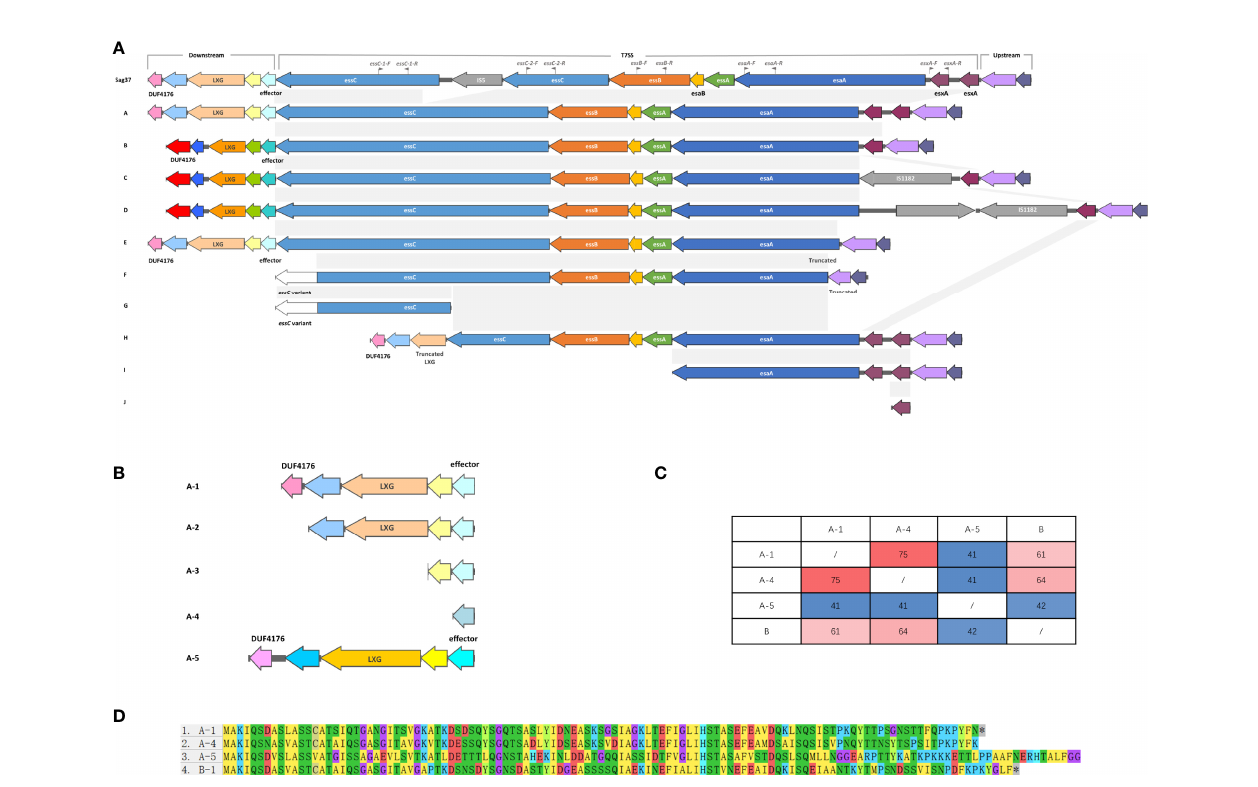
FIGURE 2 | (A) Schematic representation of the T7SS gene clusters and their fl anking genes, both upstream and downstream. In the downstream fl anking genes, genes encoding similar conserved domains/motifs are indicated with similar colors; genes in pink and light purple encode DUF4176 domain-containing proteins; genes in beige and orange encode LXG domain-containing proteins; genes in cyan and turquoise encode T7SS putative effector. In the T7SS genes, genes with coverage and percent identity greater than 99% are indicated by the same color and shaded in grey. Insertion sequences are colored in grey, as well as the gene annotated as hypothetical in Type D Downstream fl anking genes displayed few differences, except for a deletion in Type F Identical genes are indicated by the same colors. Truncated genes are indicated. Type K, entirely lacking T7SS, is not shown. Locations of the primers used in this study are indicated by grey fl ags. (B) Schematic representation of fi ve sub-patterns of the upstream sequences in Type A lacking DUF4176 domain-containing protein and/or LXG domain-containing protein. Genes encoding similar conserved domains/motifs are indicated with similar colors; gene in pink and light purple encodes DUF4176 domain-containing protein; genes in beige and orange encodes LXG domain-containing protein; gene in cyan, grey-blue and blue encodes T7SS putative effector. (C) Mutual percent identities between the different T7SS putative effectors. (D) ClustalW alignments of T7SS putative effector-encoding